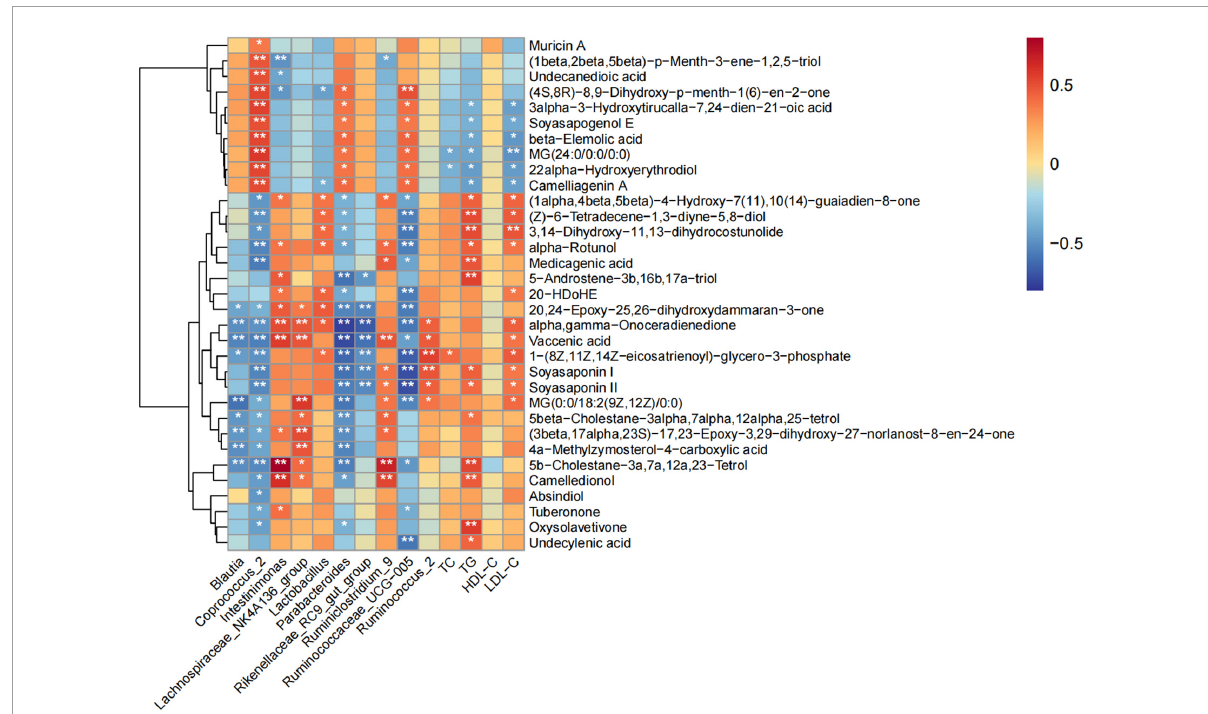
FIGURE8 Correlation between serum lipids, fecal metabolites, and gut microbiota in Spearman’s correlation coefficient. * and ** indicate statistically significant differences ( P < 0.05 and P < 0.01,